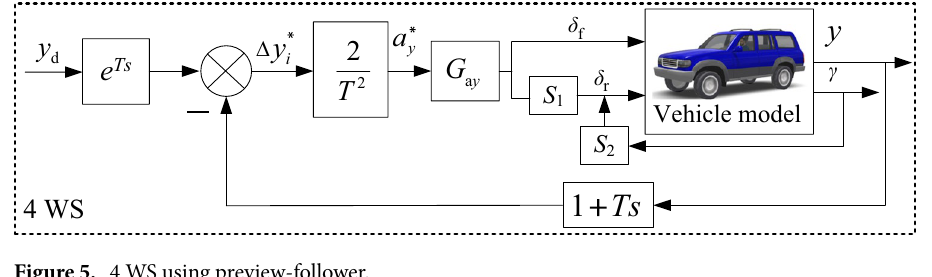
Figure 5. 4 WS using